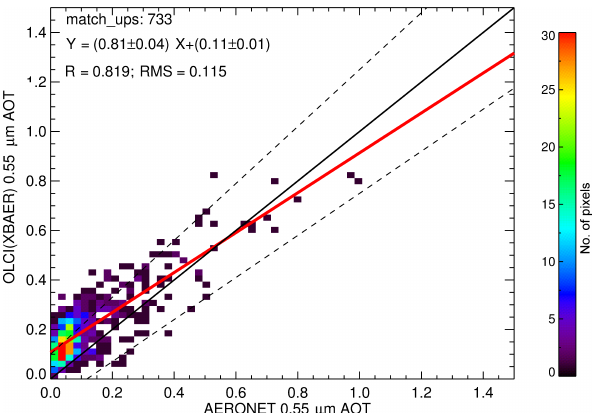
Figure 3. Global comparison of OLCI XBAER AOT with AERONET observations for 2016 December. R and “match_ups” refer to the Pearson correlation coefficient and the number of lo- cations used in the validation respectively. The dashed lines are ± 15% τ ± 0 .